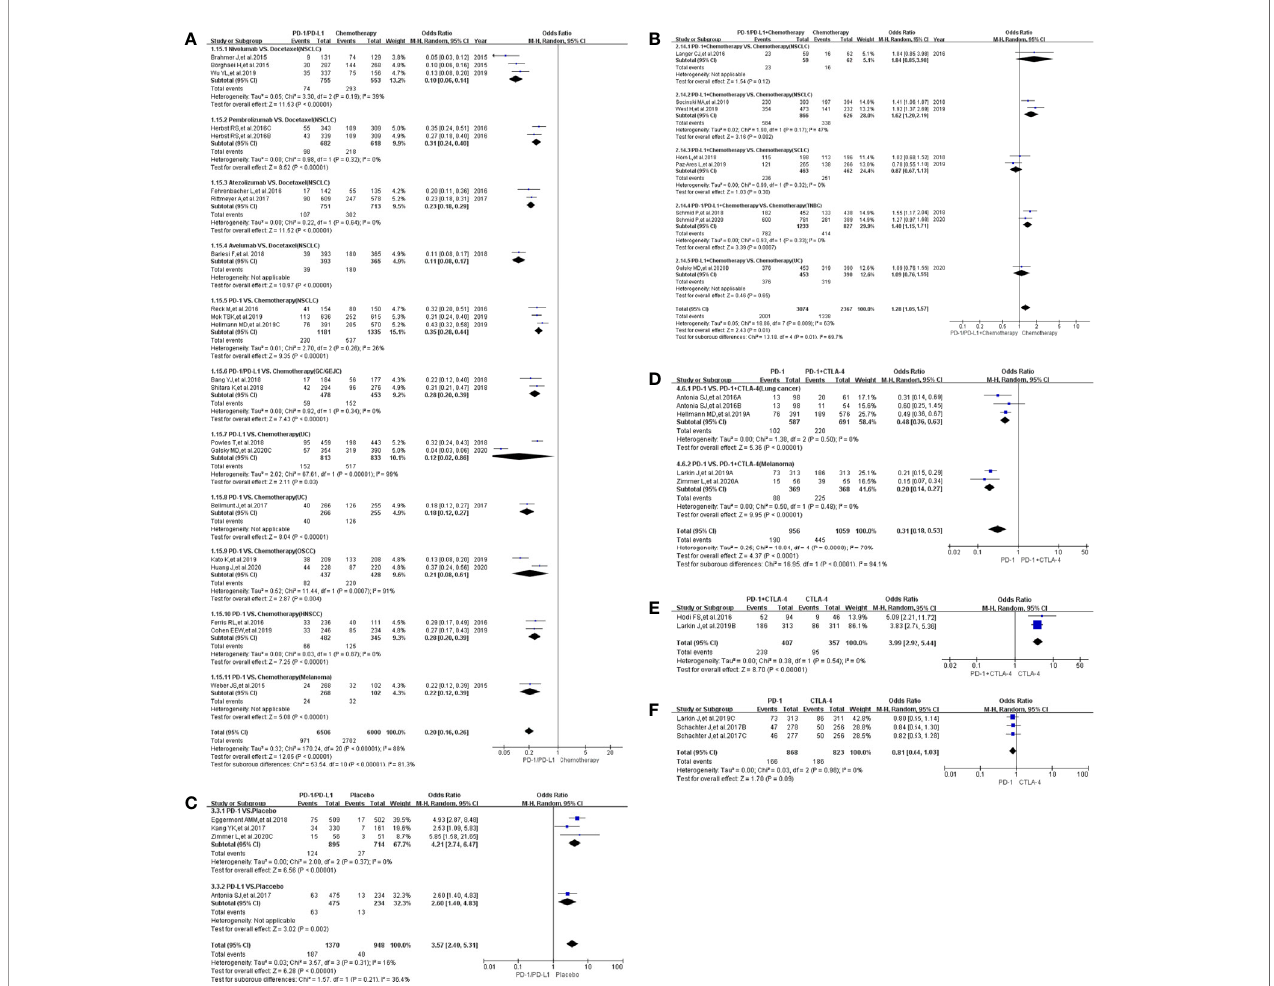
FIGURE 6 | Forest plots of the risk of grades 3 – 5 treatment-related adverse events (A) The odds ratio of grades 3 – 5 treatment-related adverse events calculated by the random effect (RE) model in Group A (PD-1/PD-L1 vs Chemotherapy). Subgroup analysis was performed based on tumor types, PD-1/PD-L1 and treatment regimens. (B) The odds ratio of grades 3 – 5 treatment-related adverse events calculated by the random effect (RE) model in Group B (PD-1/PD-L1 + Chemotherapy vs Chemotherapy). Subgroup analysis was performed based on PD-1/PD-L1 and tumor types. (C) The odds ratio of grades 3 – 5 treatment-related adverse events calculated by the random effect (RE) model in Group C (PD-1/PD-L1 vs Placebo). Subgroup analysis was performed based on PD-1/PD-L1. (D) The odds ratio of grades 3 – 5 treatment-related adverse events calculated by the random effect (RE) model in Group D (PD-1 vs PD-1 + CTLA-4). Subgroup analysis was performed based on PD-1/PD-L1 and tumor types. (E) The odds ratio for grades 3 – 5 of treatment-related adverse events calculated by the random effect (RE) model in Group E (PD-1 + CTLA-4 vs CTLA-4). (F) The odds ratio for grades 3 – 5 of treatment-related adverse events calculated by the random effect (RE) model in Group F (PD-1 vs